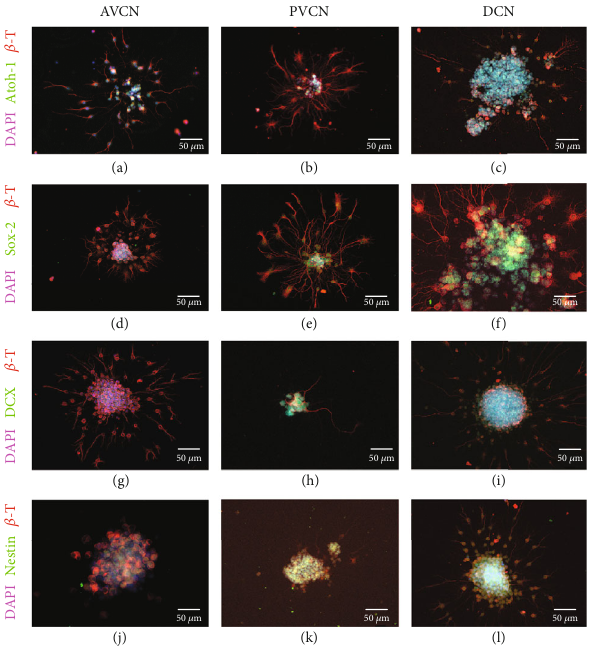
Figure 2: Neurospheres from all CN subnuclei contain neural progenitor cells. These spheres adhered to glass coverslips, coated with poly-d-lysine and laminin-1. After 48 h in NSC medium, these showed centrifugally outgrowing branches and emigrating cells, stained for β -tubulin. Cells in the neurospheres of all subnuclei showed a positive staining for the transcription factors Atoh-1 (a – c) and Sox-2 (d – f). (g – i) Neural stem cells were identi fi ed by the markers DCX (doublecortin) and nestin (j – l). Cell nuclei were stained with